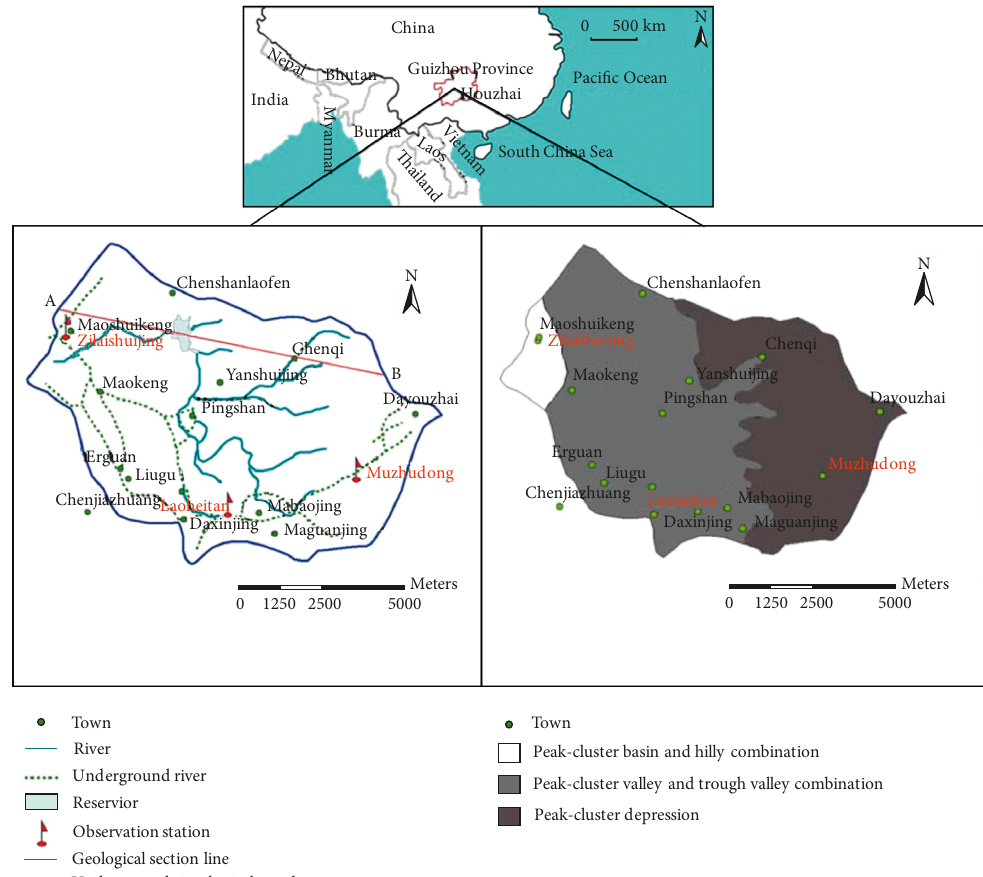
Figure 1: The location map and the landform types map of Houzhai karst basin in Guizhou Province, China